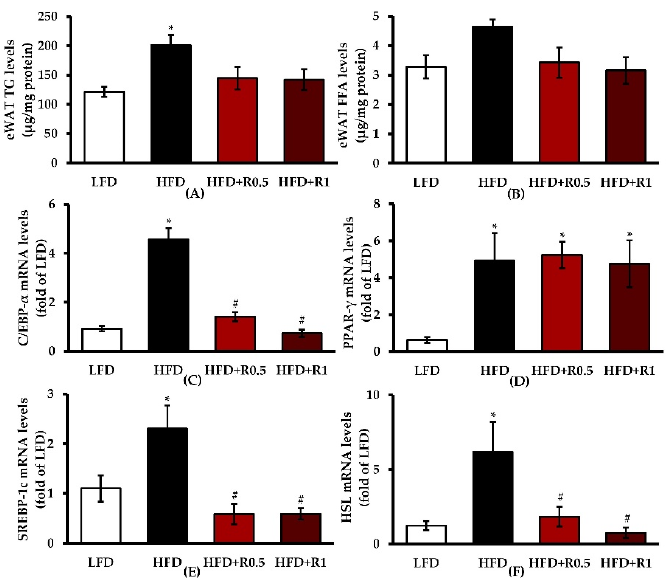
Figure 3. Effects of RRBE on lipid accumulation and adipogenic and lipid metabolism gene expression